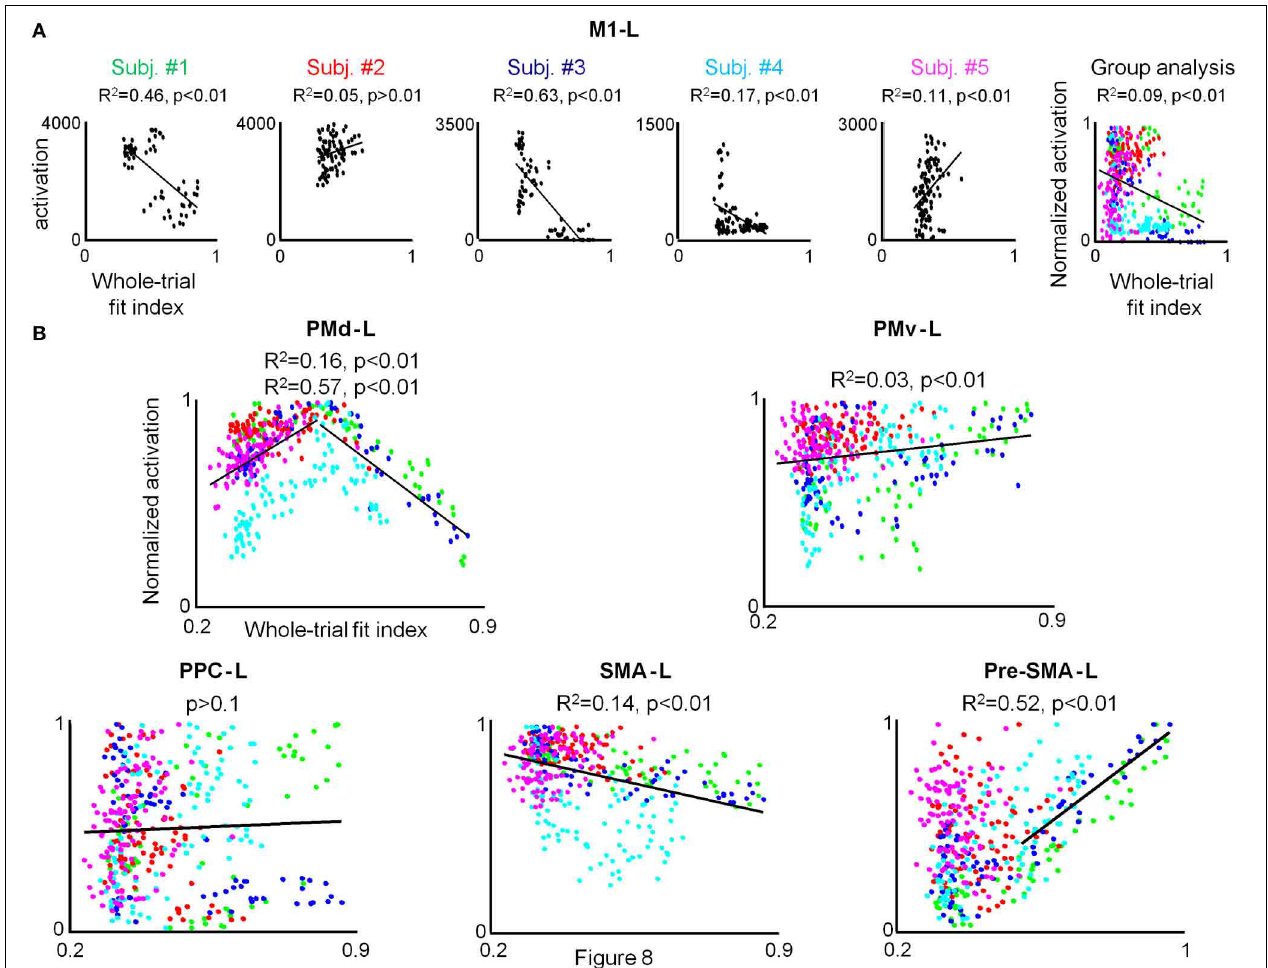
respectively) between the two descriptors are indicated and the regression line is depicted. The rightmost plot depicts group analysis. The green, red, blue, cyan, and magenta colored dots denote normalized data from subject #1, #2, #3, #4, and #5, respectively. (B) Group analysis for PMd-L, PMv-L, SMA-L, pre-SMA-L, and PPC-L. Color coding as for (A)